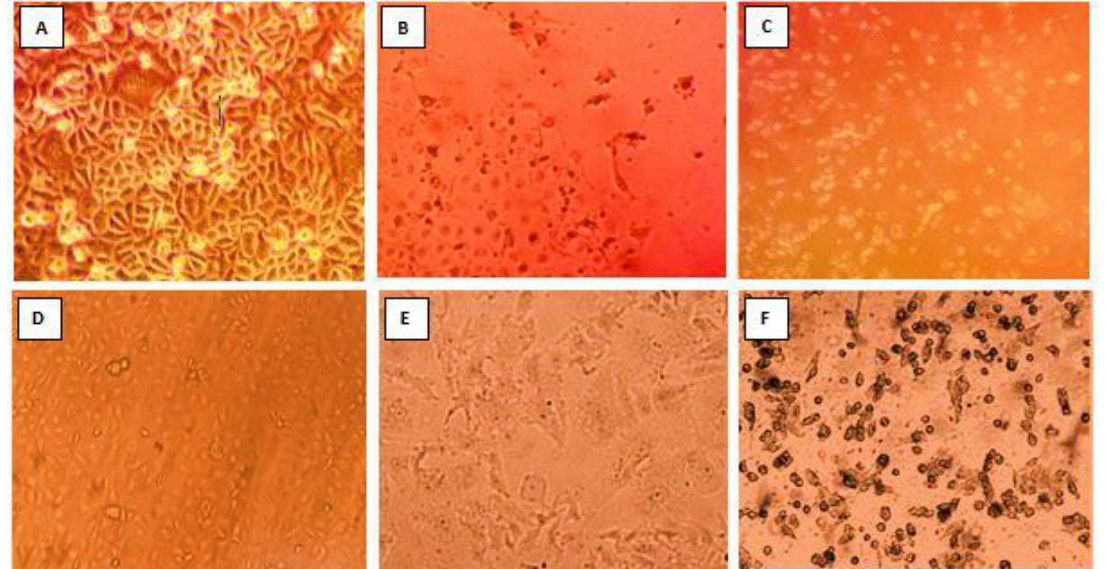
Figure 2. Development of cytopathic effect on Caco-2 and MA104 cell lines during isolation of rotavirus: ( A ) control Caco-2 cell line after 3 days of propagation; ( B ) infected Caco-2 by positive sample of rotavirus showing partial CPE; ( C ) infected Caco-2 cells by positive sample of rotavirus showing complete CPE; ( D ) control MA104 cells after 3 days of propagation; ( E ) infected MA104 by positive sample of rotavirus showing partial CPE; ( F ) infected MA104 by positive sample of rotavirus showing complete CPE. Table 2. Propagation of positive rotavirus samples * using MA104 and Caco-2 cell lines.